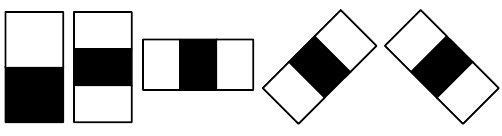
Figure 3. Sample Haar-like features used in our